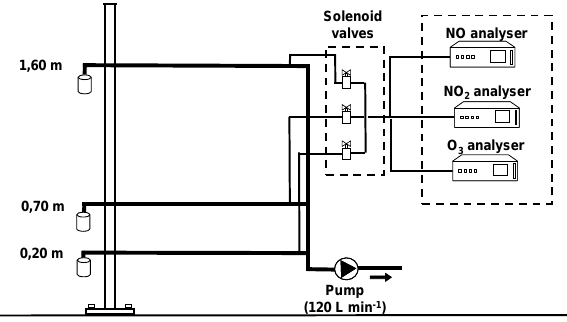
Figure 1: Measurement set-up for the determination NO-O 3 -NO 2 fluxes using aerodynamic 14 Fig. 1. Measurement set-up for the determination NO-O 3 -NO 2 gradient method. 15 fluxes using aerodynamic gradient